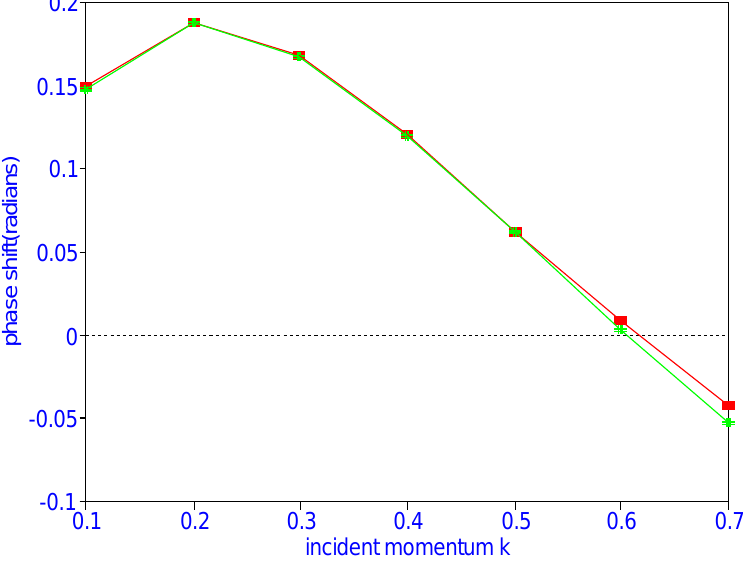
Figure 1. (Color online) The upper curve represents the present results, while the lower curve represents results obtained by Bhatia et al. (1971) [9].